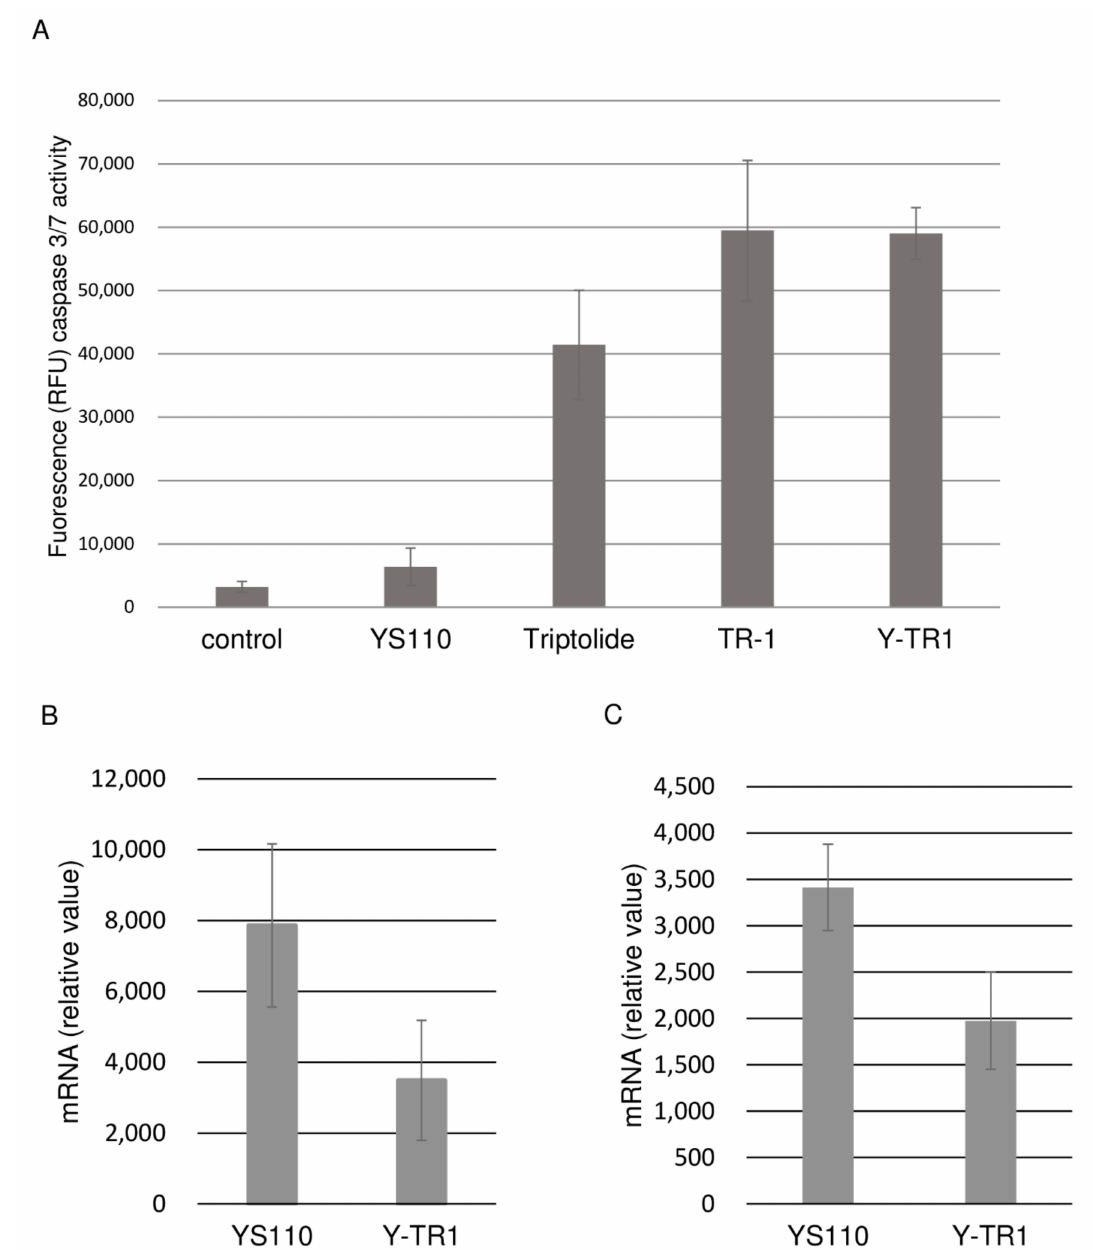
Figure 6. Investigation into the cytotoxic e ff ect of TR-1. ( A ) Caspase 3 / 7 activity (represented in fluorescence) after 48 h of treatment with YS110, triptolide, TR1, and Y-TR1 in the CD26-positive MM cell line MSTO clone12. The activity is elevated in triptolide-, TR1-, and Y-TR1-treated cells. The vertical axis shows the intensity value measured by the fluorometer; ( B , C ) e ff ects of Y-TR1 on the mRNA levels of HSP70 after heat induction. Relative mRNA levels of HSP70 after heat induction (45 ◦ C, 2 h) were significantly lower in Y-TR1-treated cells compared to unconjugated YS110-treated cells in CD26-positive MM cell lines. A t -test at the p = 0.05 level was carried out as statistical analysis ( n = 10). The error bar indicates one standard deviation; ( B ) MSTO clone12; ( C )